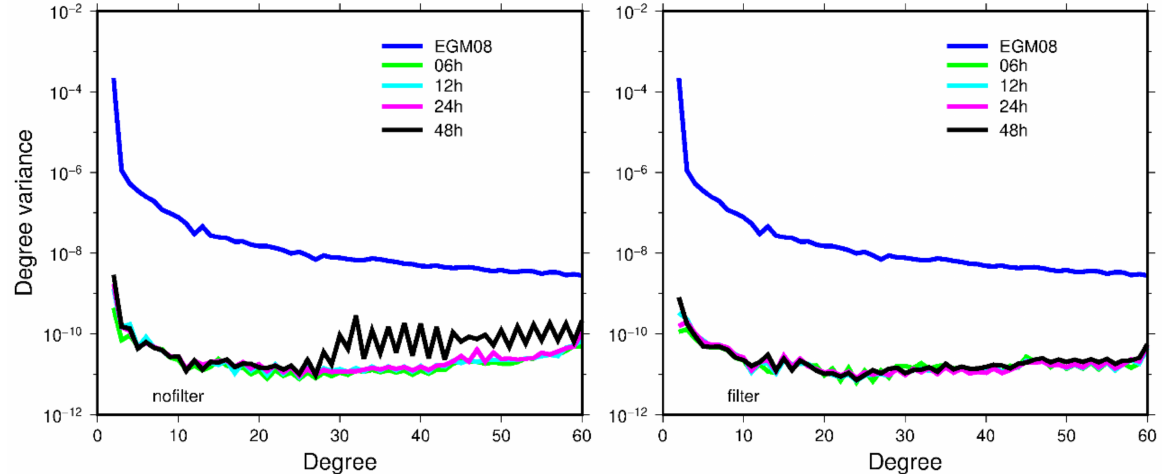
Figure 6. The degree variance of the recovered gravity field by using 6, 12, 24, and 48 h arcs, respectively. (The left expresses do not process the low-frequency error of residual orbit; the right expresses the process of the low-frequency error of residual orbit.).